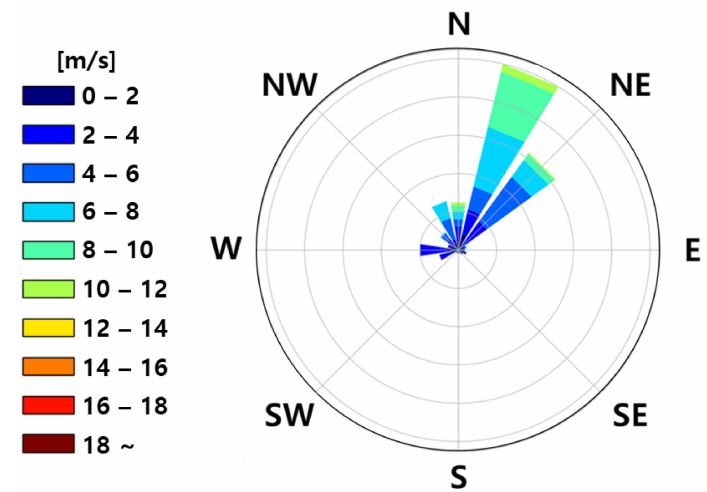
Figure 7. Windrose at AWS.